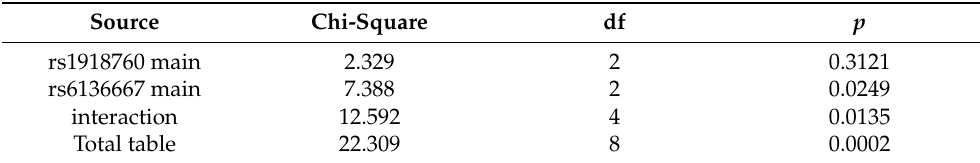
Table 1. Partitioning of chi-square for the two genotypes in the most significant genotype pattern for the Opioid dataset. The interaction effect is more significant (smallest p -value) than either of the two main effects.